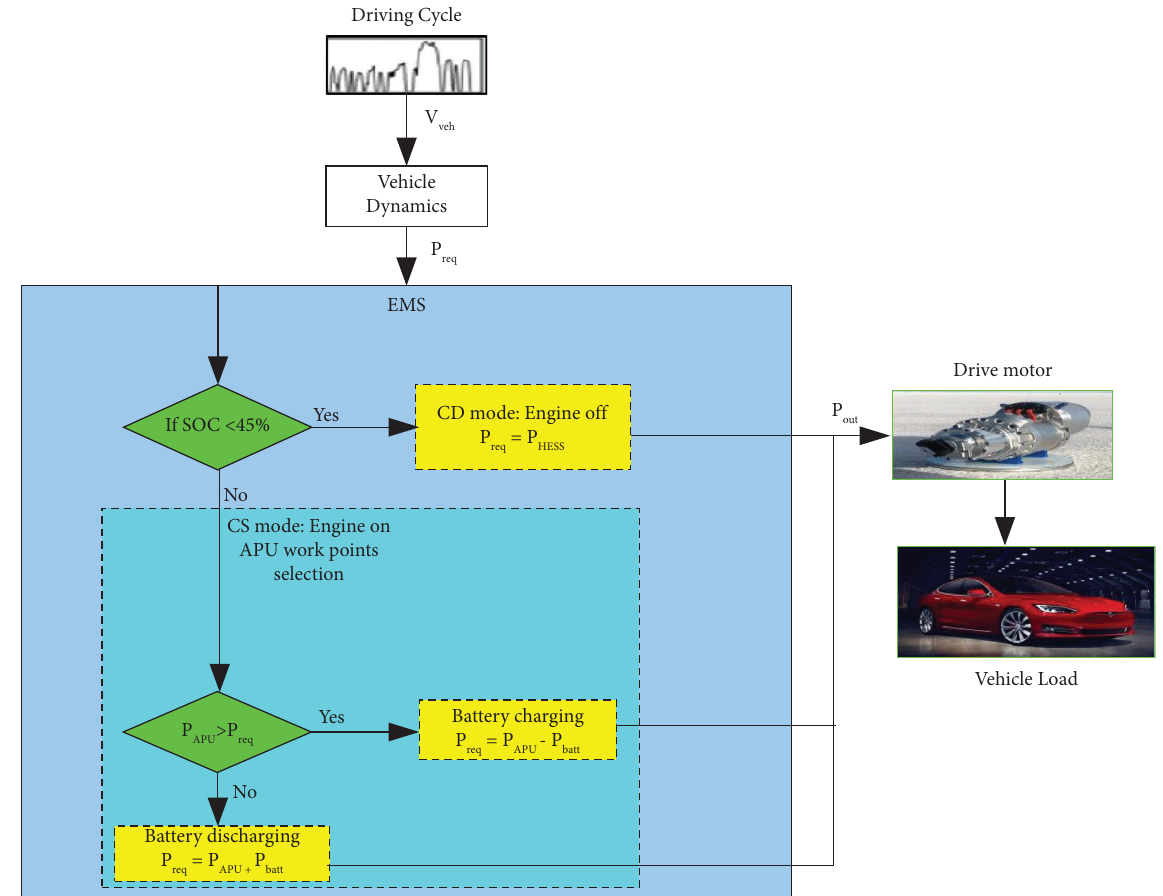
Figure 13: Logic diagram for optimal control strategy